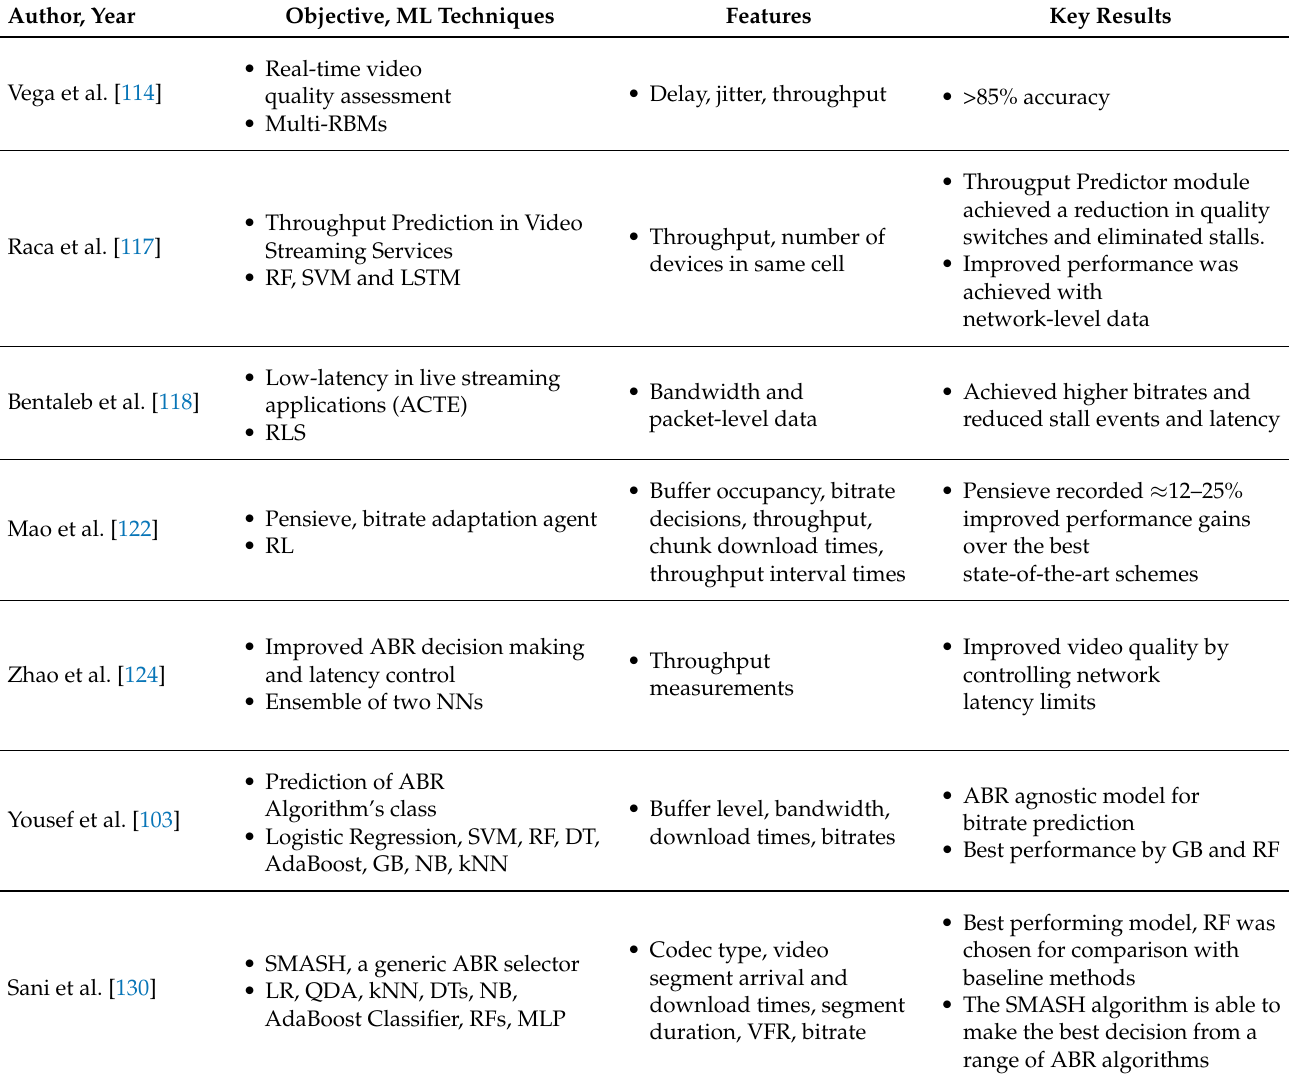
Table 2. Summary of video quality prediction under QoD